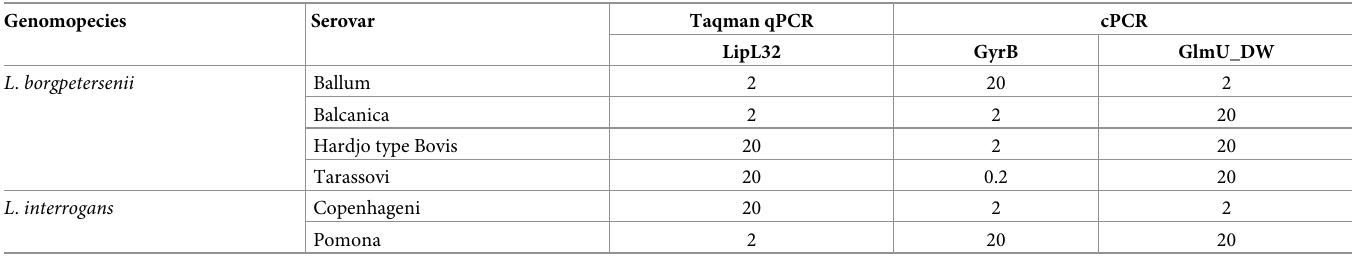
Limits of detection are expressed as the estimated number of copies of Leptospira genomes in the least concentrated sample of a serial dilution that gave a positive PCR